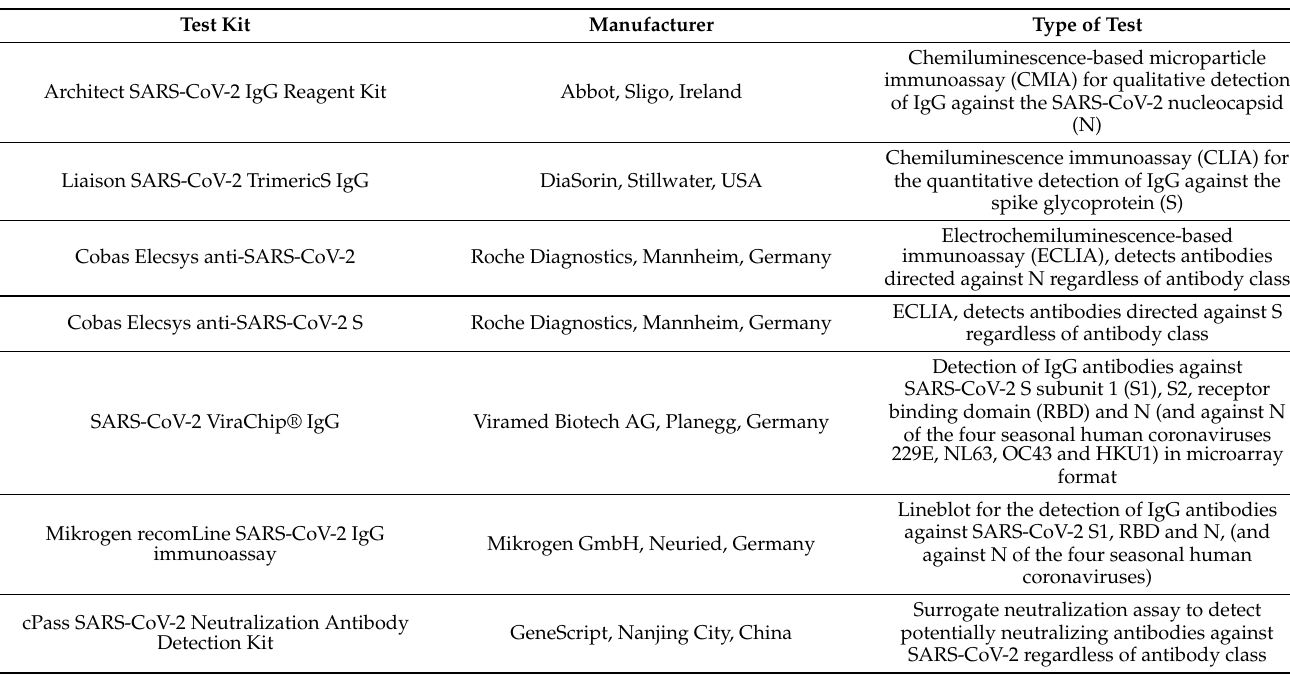
Table 1. Summary of all test kits used to determine α -SARS-CoV-2 antibody